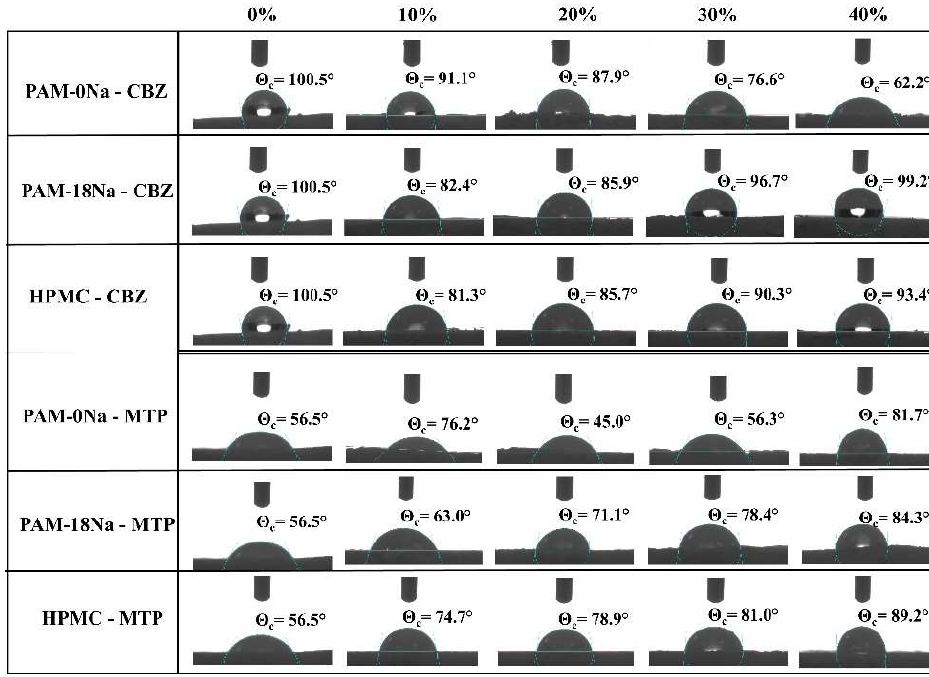
Figure 3. Contact angle values for tablets elaborated with CBZ and MTP in different proportions of PAM-0Na, PAM-18Na and HPMC polymers.